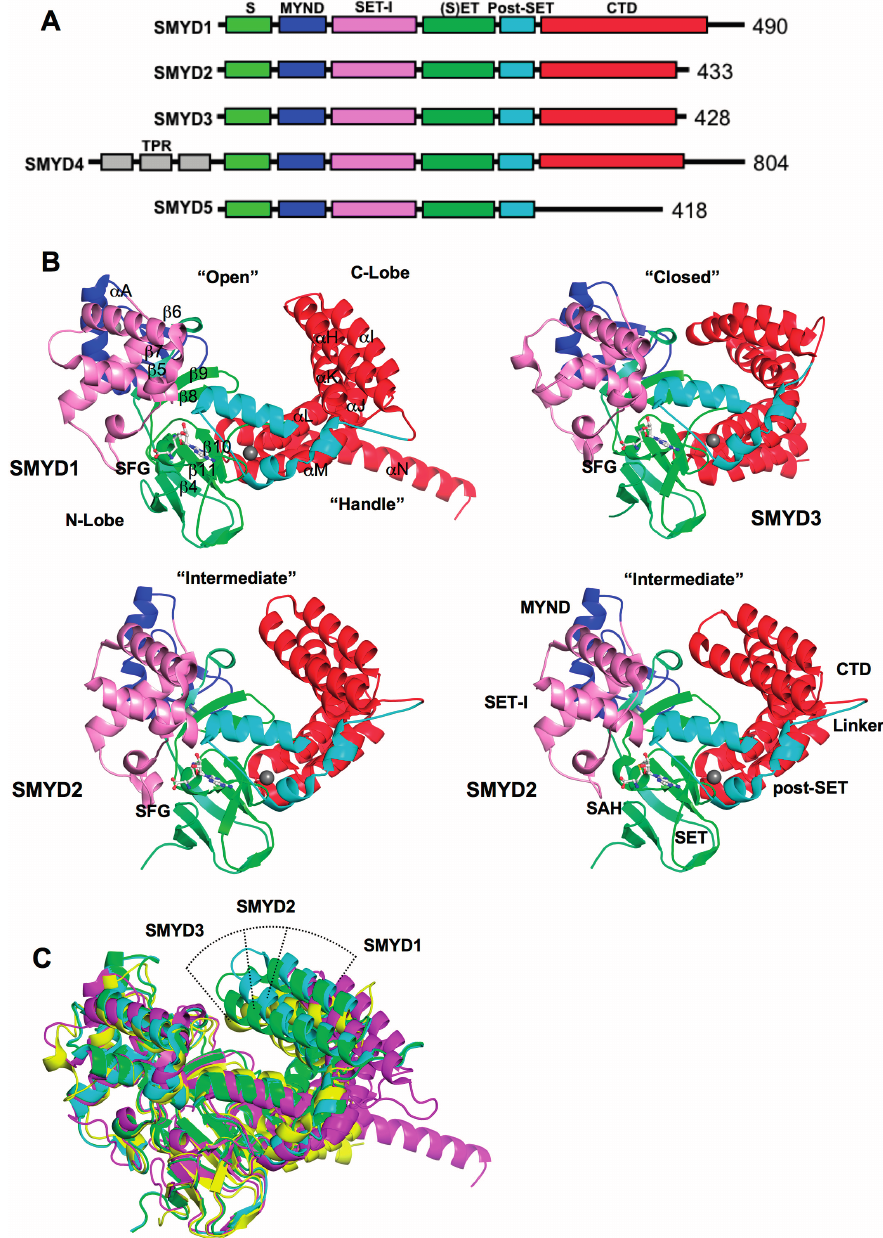
Figure 1. Overall structure of SET and MYND domain-containing proteins (SMYD) proteins. ( A ) Domain diagram of SMYD protein family. S, S-sequence; MYND (Myeloid, Nervy, DEAF1); SET-I, insertion SET (Su(Var)3-9, Enhancer-of-zeste, Trithorax) domain; (S)ET, core SET domain; Post-SET, SET C -terminal flanking domain; CTD, C -terminal domain; ( B ) Ribbon diagram of SMYD1 (PDB code: 3N71), SMYD2 (PDB code: 3QWV and 3QWW), and SMYD3 (PDB code: 3PDN). The S-sequence, MYND, SET-I, core SET, post-SET, and CTD are depicted in light green, blue, pink, green, cyan, and red. Secondary structures, α -helices and β -strands are labeled and numbered according to their position in the sequence. Cofactors, sinefungin (SFG) and S -adenosyl- L -homocysteine (SAH), are depicted in balls and sticks; and ( C ) Structural superposition of SMYD proteins: SMYD1 (magenta), SMYD2 (SFG, cyan; SAH, green), and SMYD3 (yellow). The superposition is based on the N -terminal